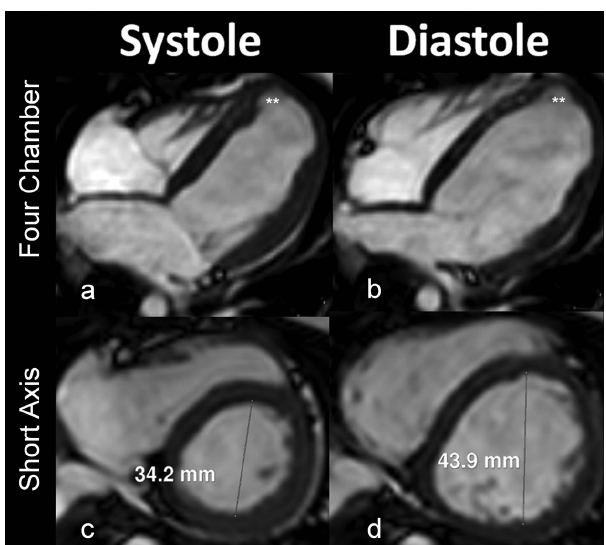
Figure 1 - Magnetic resonance images taken during cardiac systole and end diastole. The images above the plane show four chambers with aneurysmal formation of the left ventricle, and the images below demonstrate ventricular